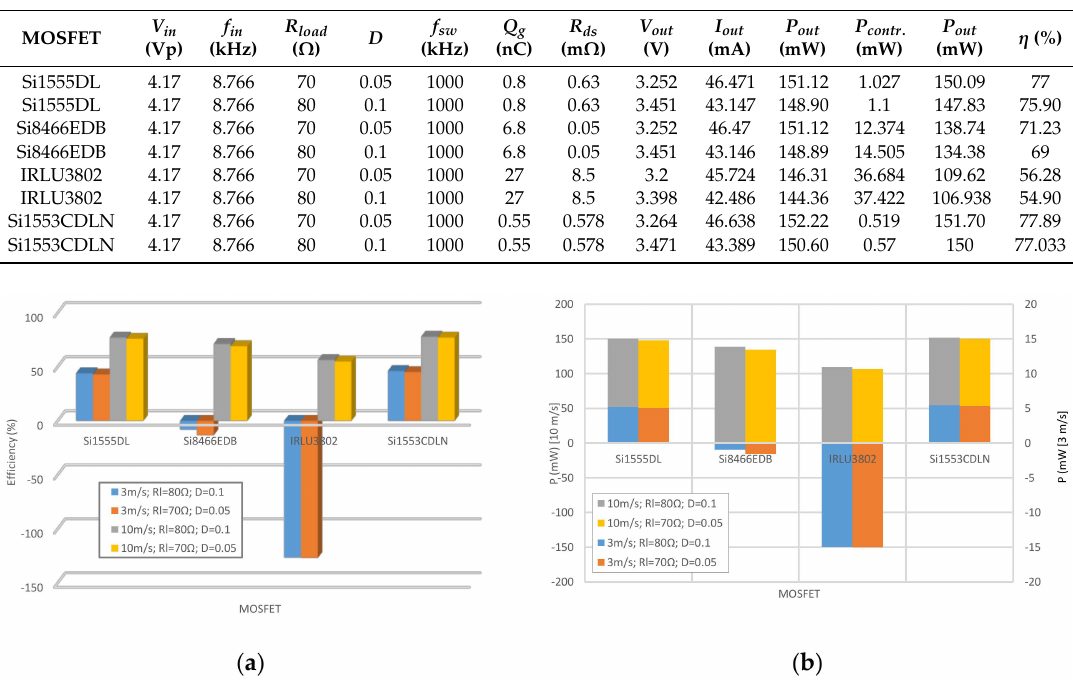
Figure 30. Comparisons between diodes at 3 m / s and 10m / s. ( a ) E ffi ciency. ( b ) Output